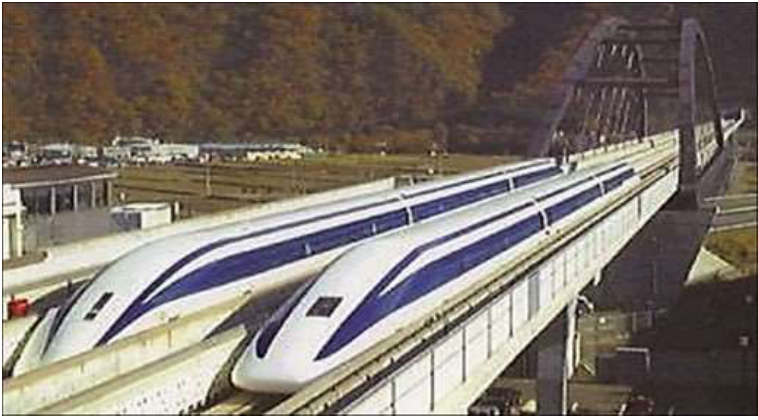
Figure 8: Magnetic Levitation Trains (Maglev) [73].